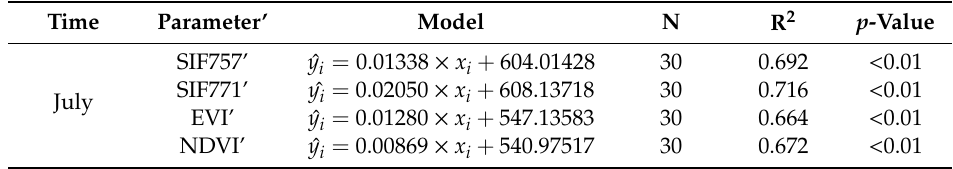
Table 2. Best-fit models for each parameter’, which was used to estimate the autumn crop production in